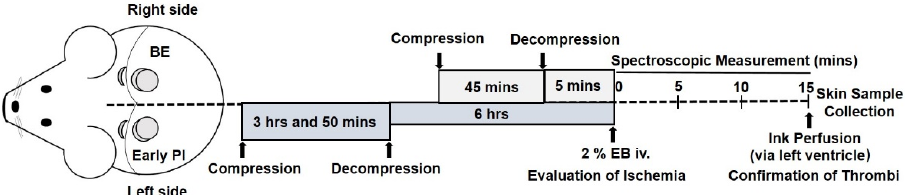
Figure 1. Schematic illustration of blanchable erythema and early pressure injury models in rats. Blanchable erythema (BE) and early pressure injury (PI) were produced in rats by pressing the dorsal skin for different time periods. A 2% Evans Blue (EB) solution was intravenously injected to evaluate ischemia, and ink was perfused from the left ventricle to distinguish thrombi and post-mortem blood clots. i.v.: intravenous injection.